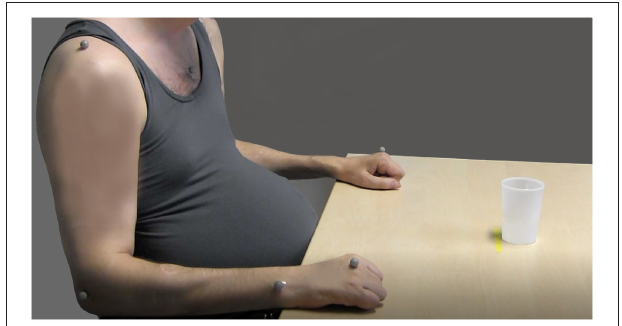
FIGURE 2 | The initial sitting position and marker placements on the body for the kinematic drinking task shown in a participant with spinal cord injury (SCI) (the markers on the head, left shoulder, and the drinking glass are not visible) (source corresponding